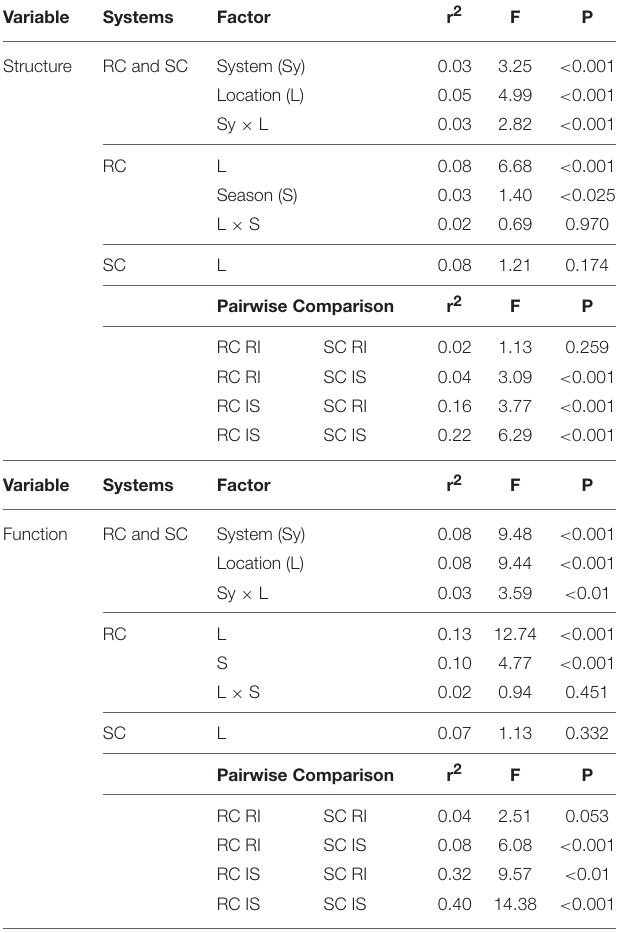
TABLE 2 | PERMANOVA of BCC and